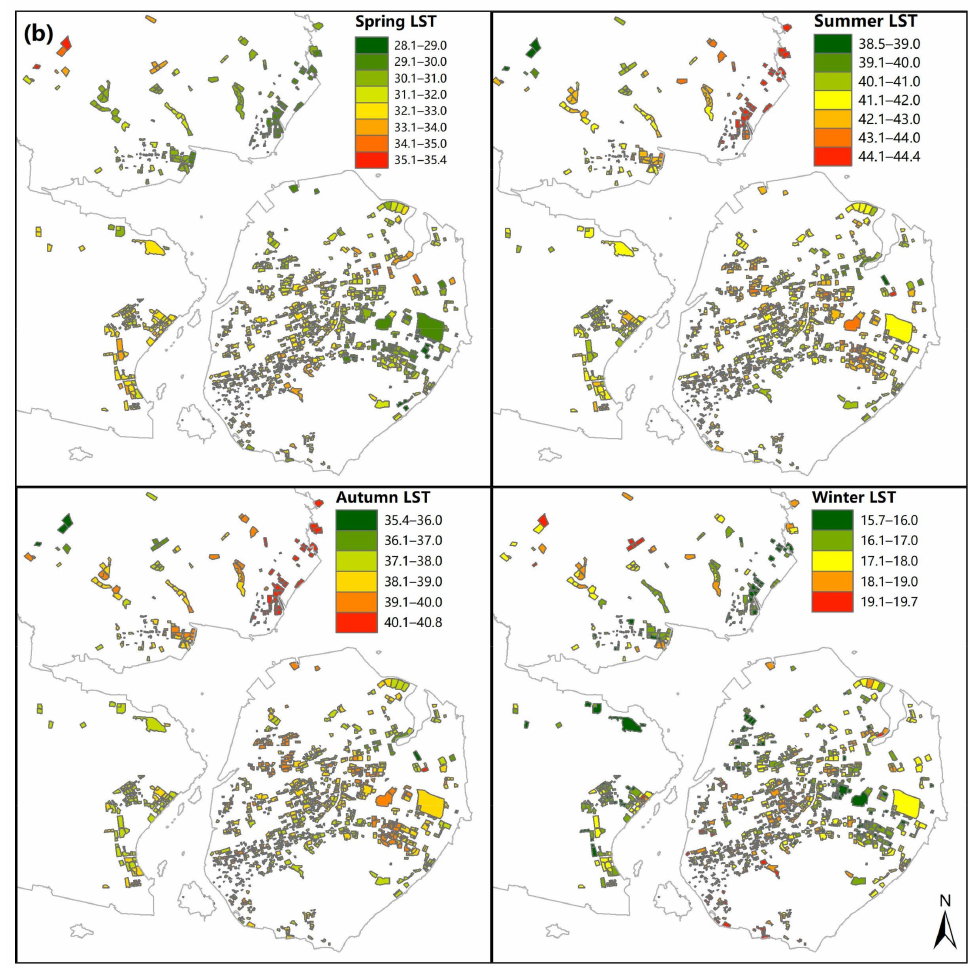
Figure 9. Spatial distribution of the heat accumulation in each community of the study area, ( a ). Spatial distribution of the LST across four seasons in each community of the study area, ( b